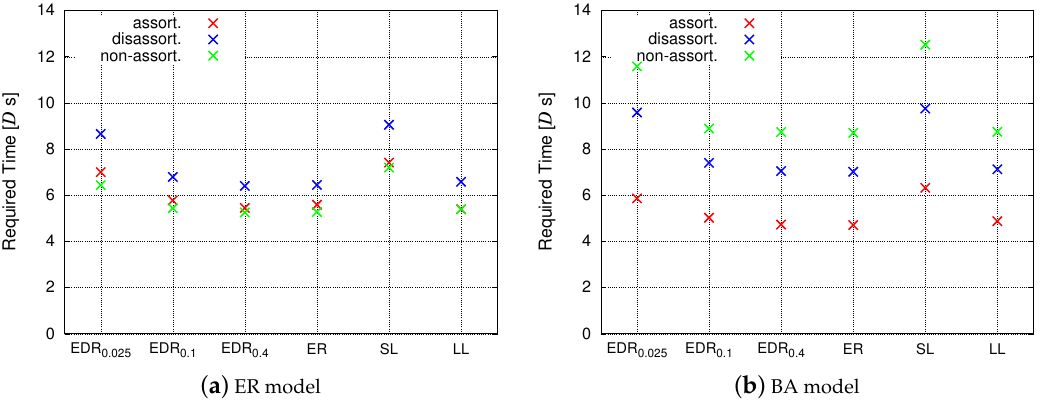
Figure 13. Communication efficiency (service